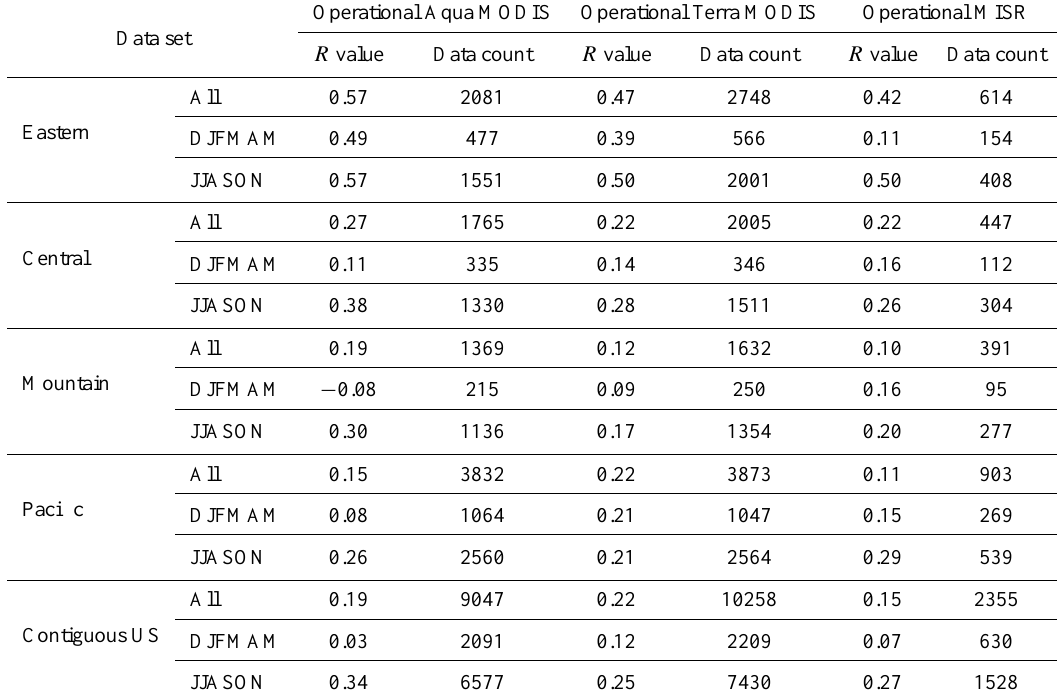
Table 1. Correlation coefficients and data counts of the daily 1 ◦ × 1 ◦ average operational/DA Aqua/Terra MODIS and MISR AOD/daily PM 2 . 5 collocation analyses for the eastern, central, mountain, and Pacific time zones and contiguous United States total for the entire